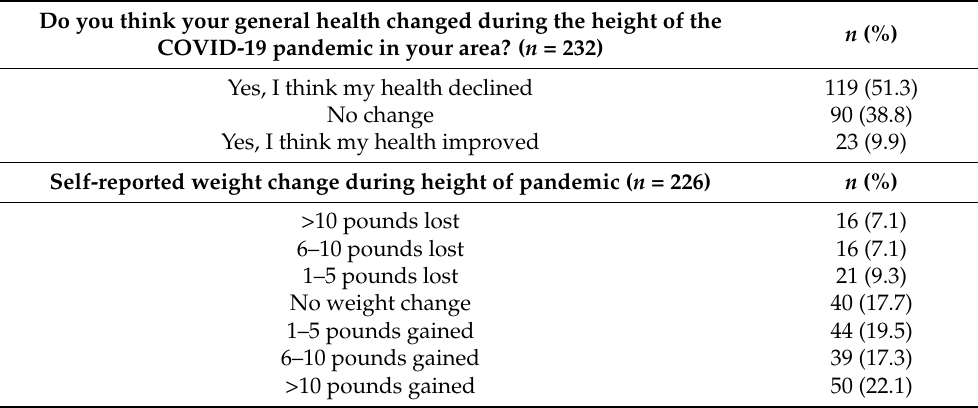
Table 2. Self-reported health and weight changes: prior to pandemic (PP0) to baseline (M0).